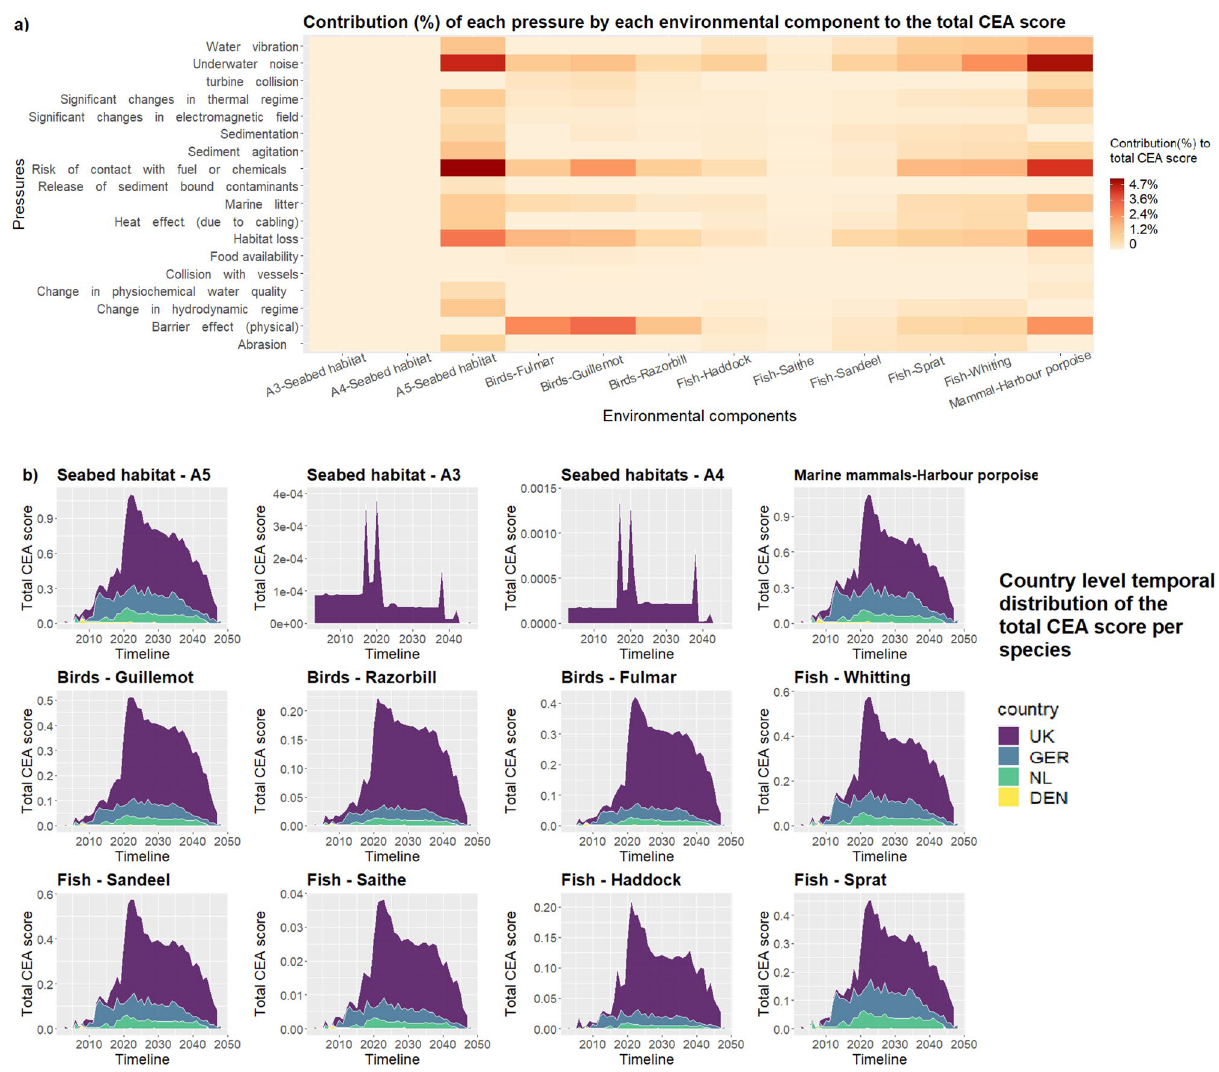
Figure 4. ( a ) Contribution (%) of each pressure by each environmental component to the total CEA score; ( b ) country level temporal distribution of the contribution of pressures to the total CEA score (1999–2050), by country, for the analysed environmental